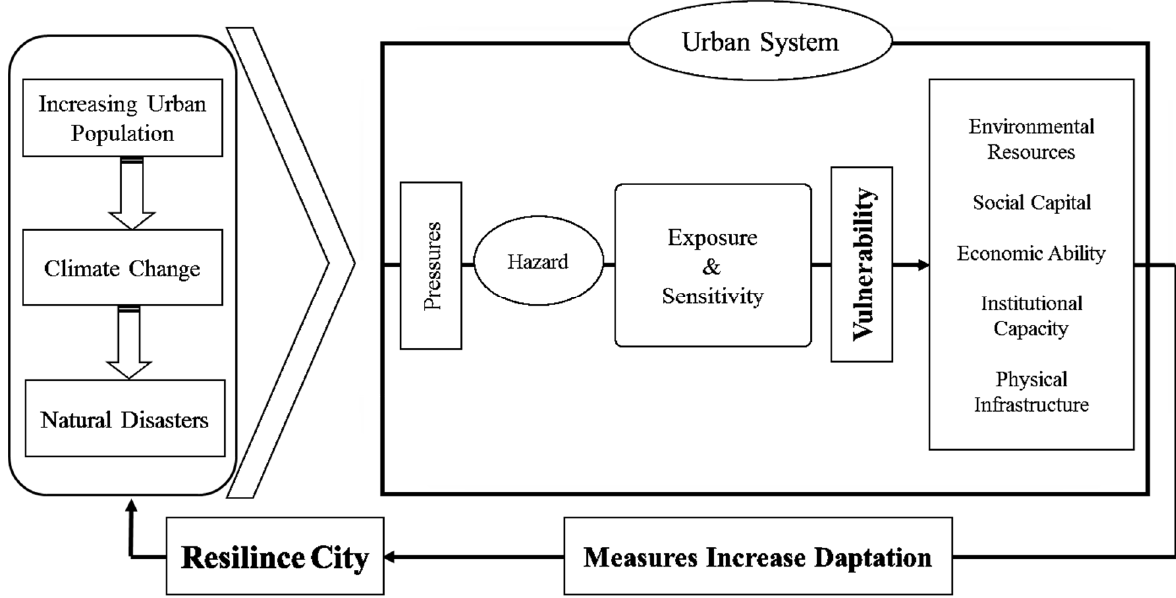
Figure 2. The conceptual relationship between natural disasters, vulnerability, adaptation, and urban resilience.